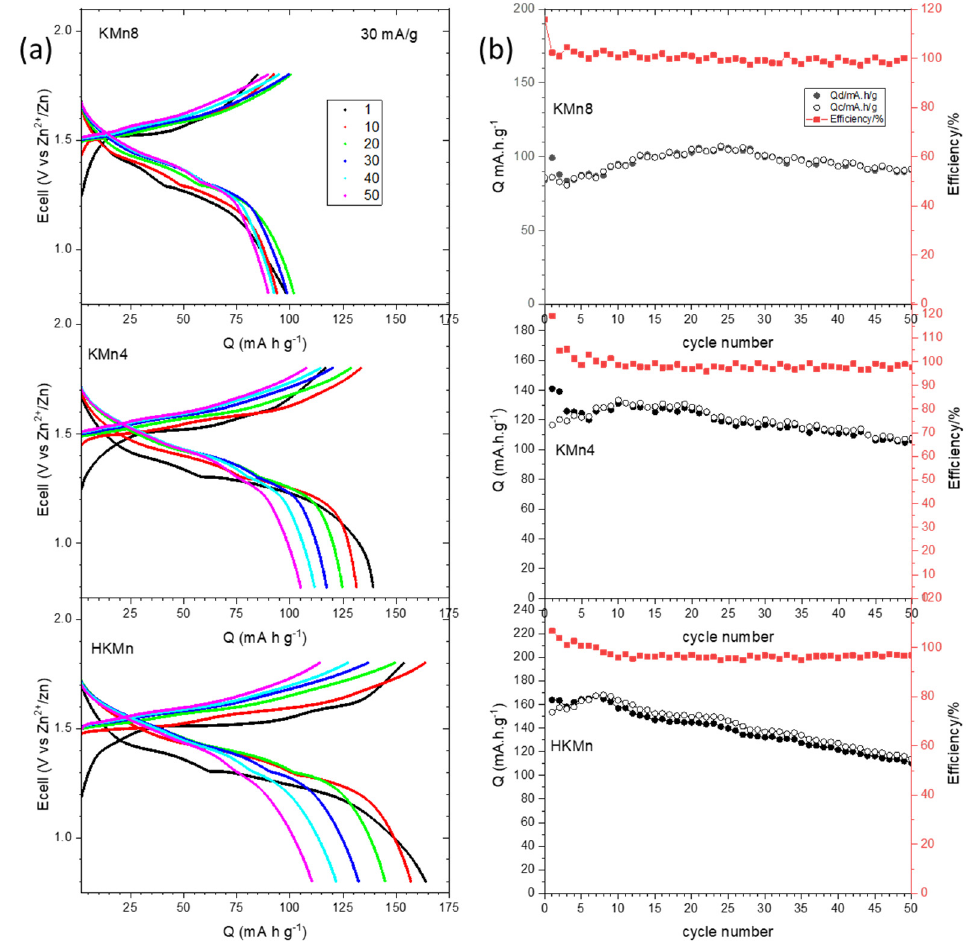
Figure 5. ( a ) Charge–discharge profiles at 30 mA g − 1 and ( b ) specific capacity and efficiency for KMn8, KMn4 and HKMn during 50 cycles.